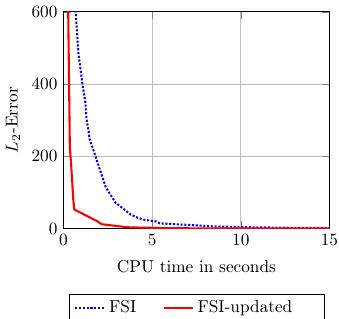
Figure A5. Results of the two-dimensional GES experiment without source: comparison of the L 2 -error and the corresponding CPU time between FSI and FSI-updated at t F = 2.609 h = 0.04. The reference solution is computed with the EE method. The scheme FSI-updated clearly outperforms their counterpart without inner